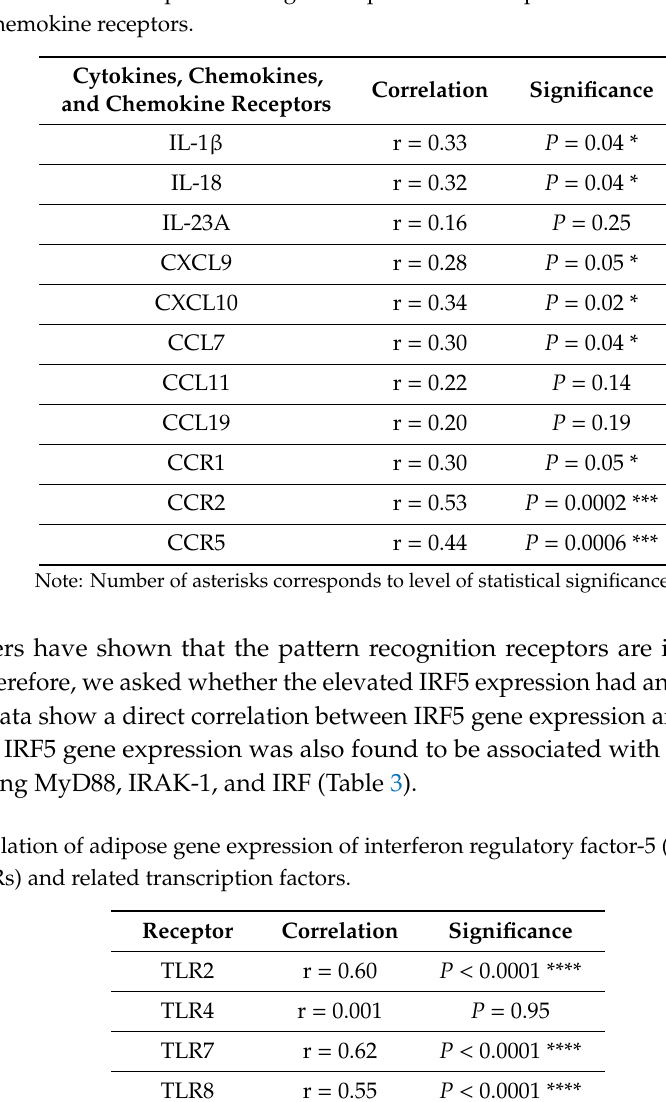
Correlation of adipose IRF5 gene expression with proinflammatory cytokines and